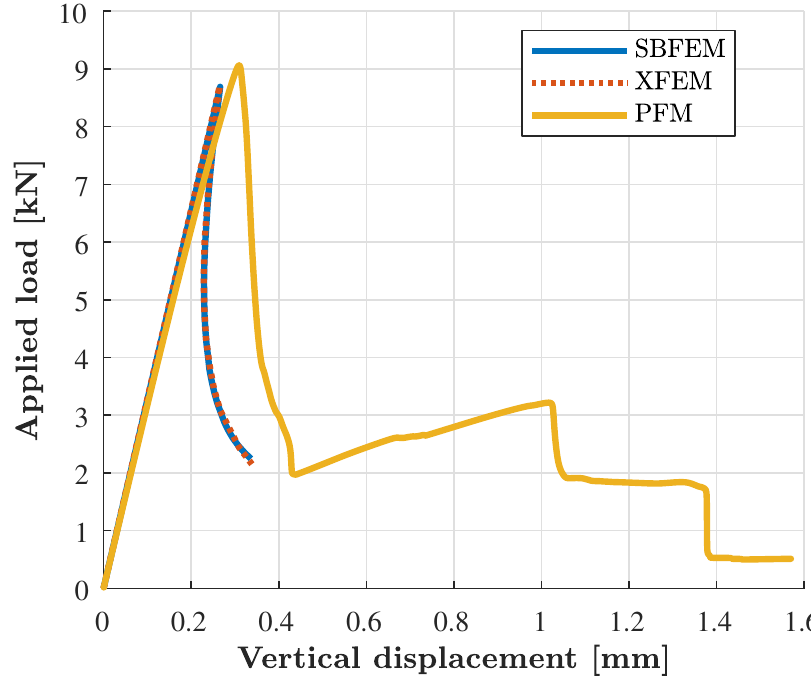
Figure 24. NPwH load-deflection curves.